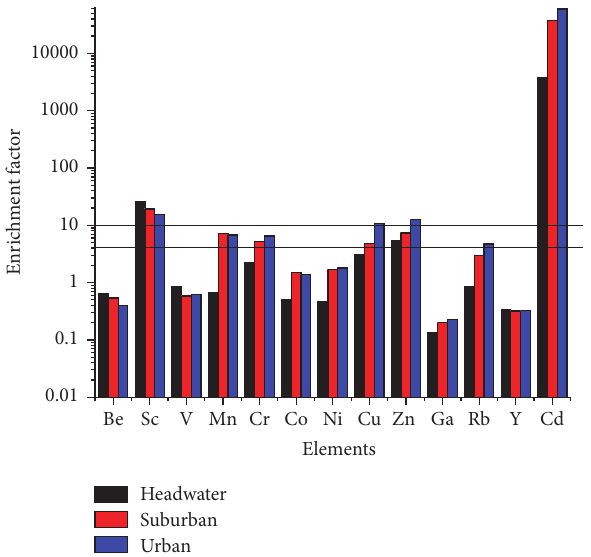
Figure 4: Average enrichment factor of trace elements in the water of Bagmati River basin presented as three sections: headwaters and suburban and urban areas within the Kathmandu Valley. Table 4: Principal Component Analysis (PCA) of elements in the Bagmati River basin within Kathmandu